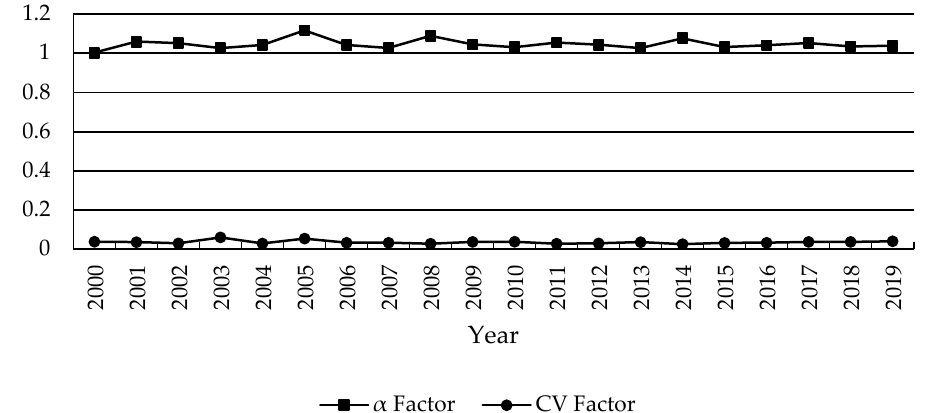
Figure 1. Trend of α convergence of AGTFP in China. Note: CV represents coefficient of variation. (2) Empirical Results and Analysis of Absolute β Convergence